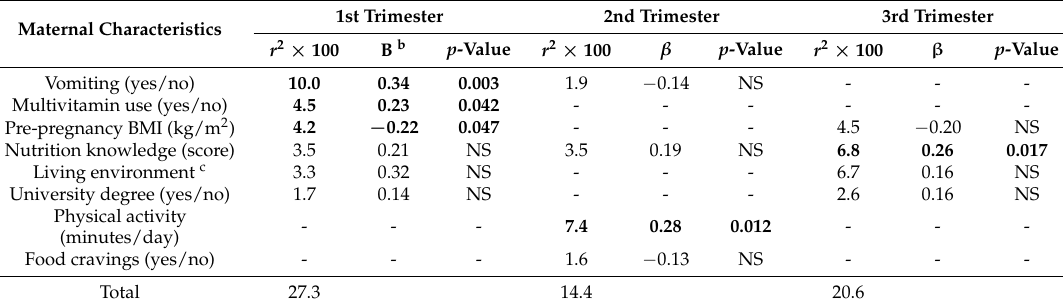
Table 4. Stepwise regression analyses of trimester-specific HEI scores.